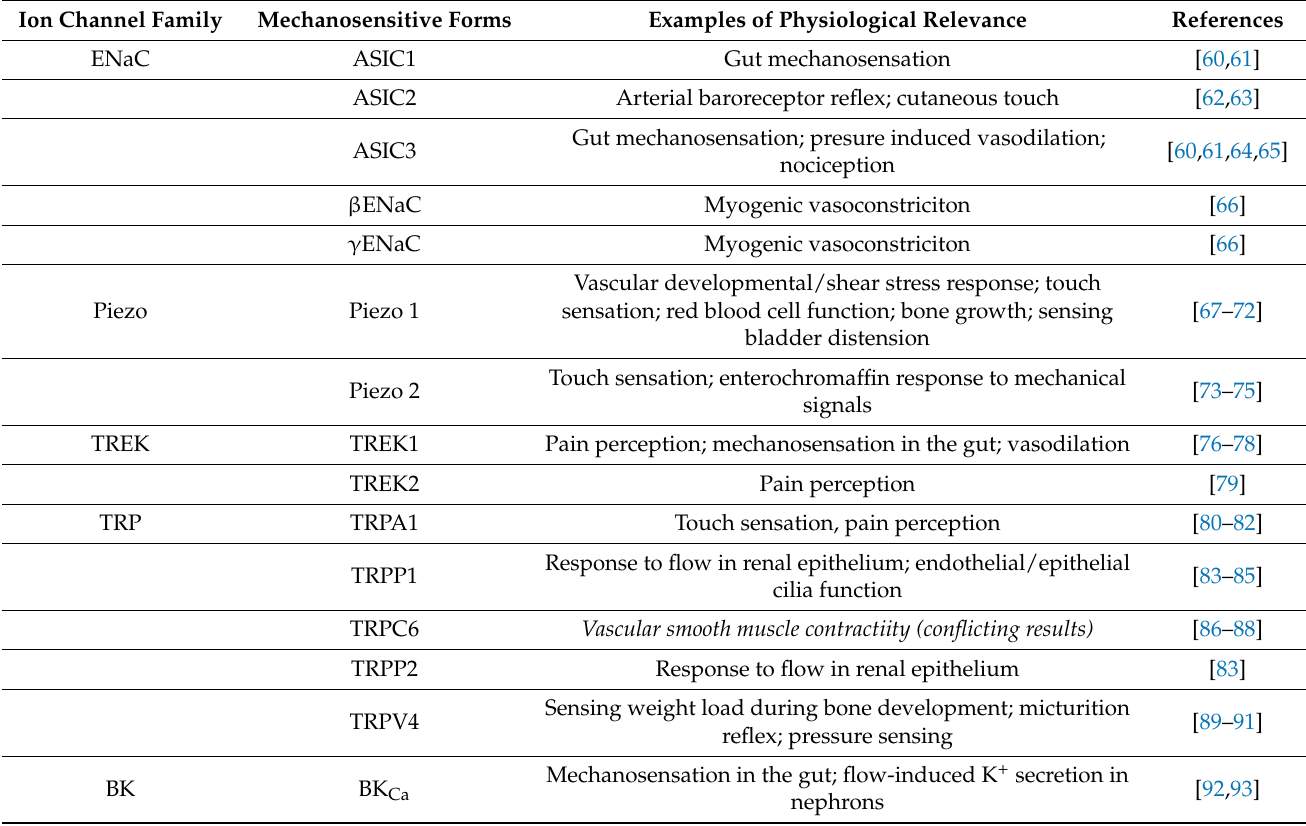
Table 1. The diverse roles of mechanosensitive mammalian ion